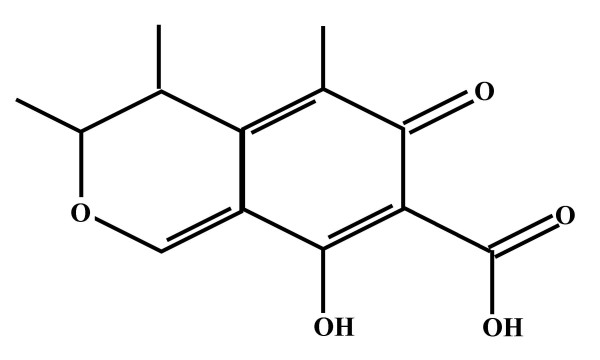
Chemical structure of citrinin.